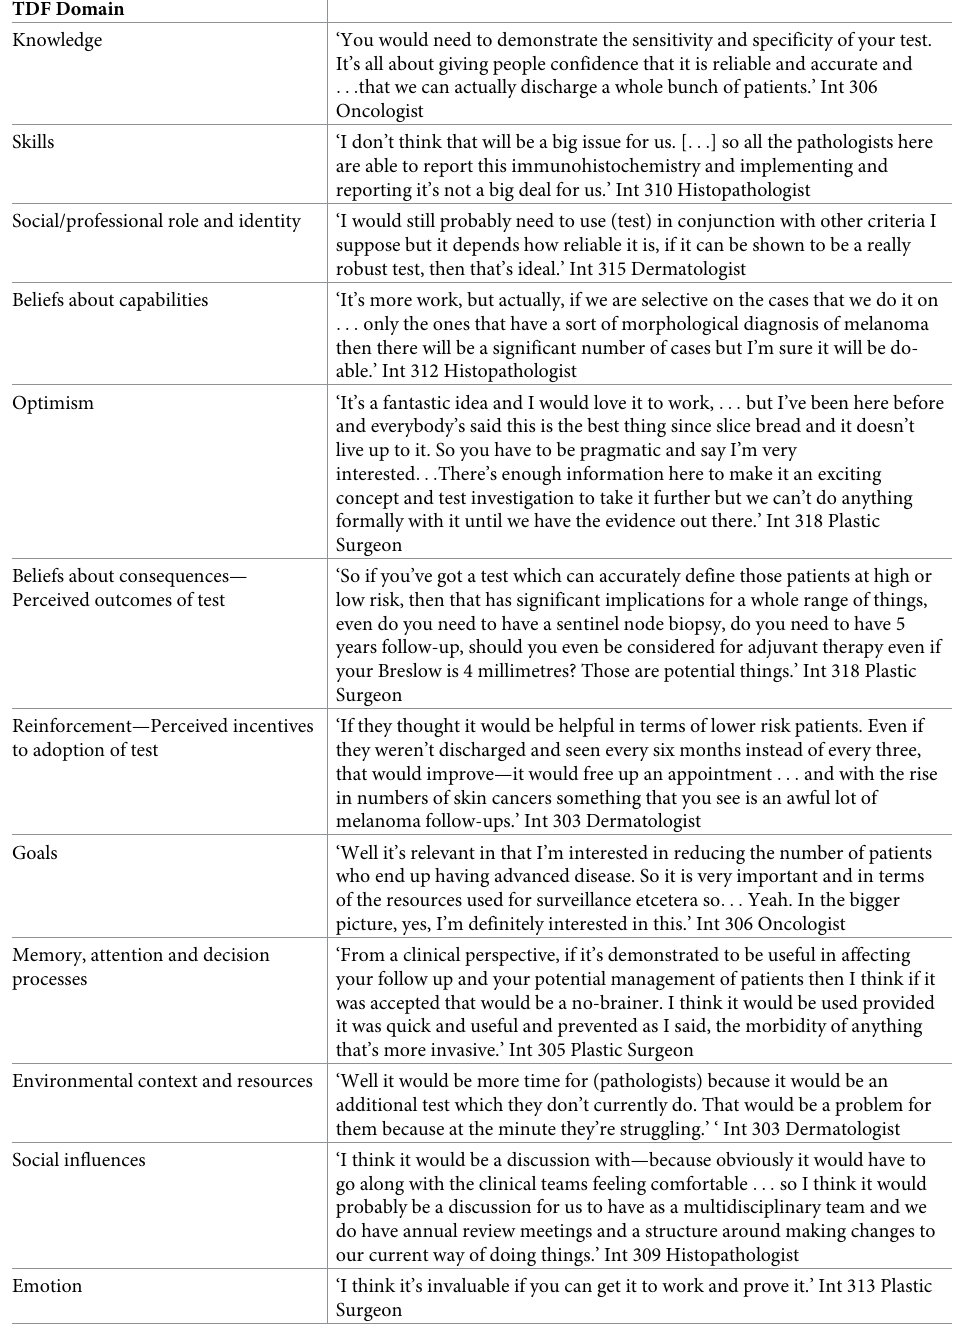
Table 2. Theoretical Domains Framework and illustrative clinician